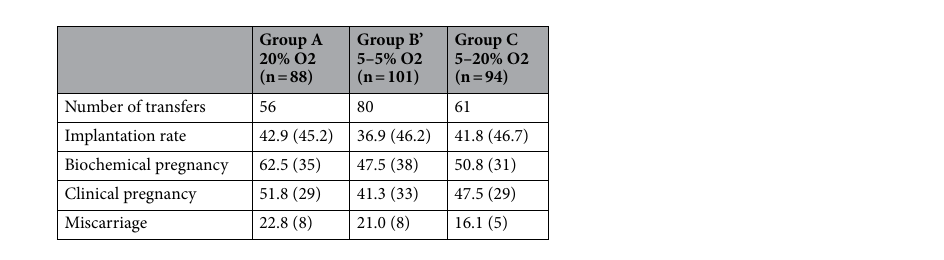
Table 5. Comparison of clinical outcomes following blastocyst transfer between groups A, B’ and C. Data are presented as mean (SD) or % (n).